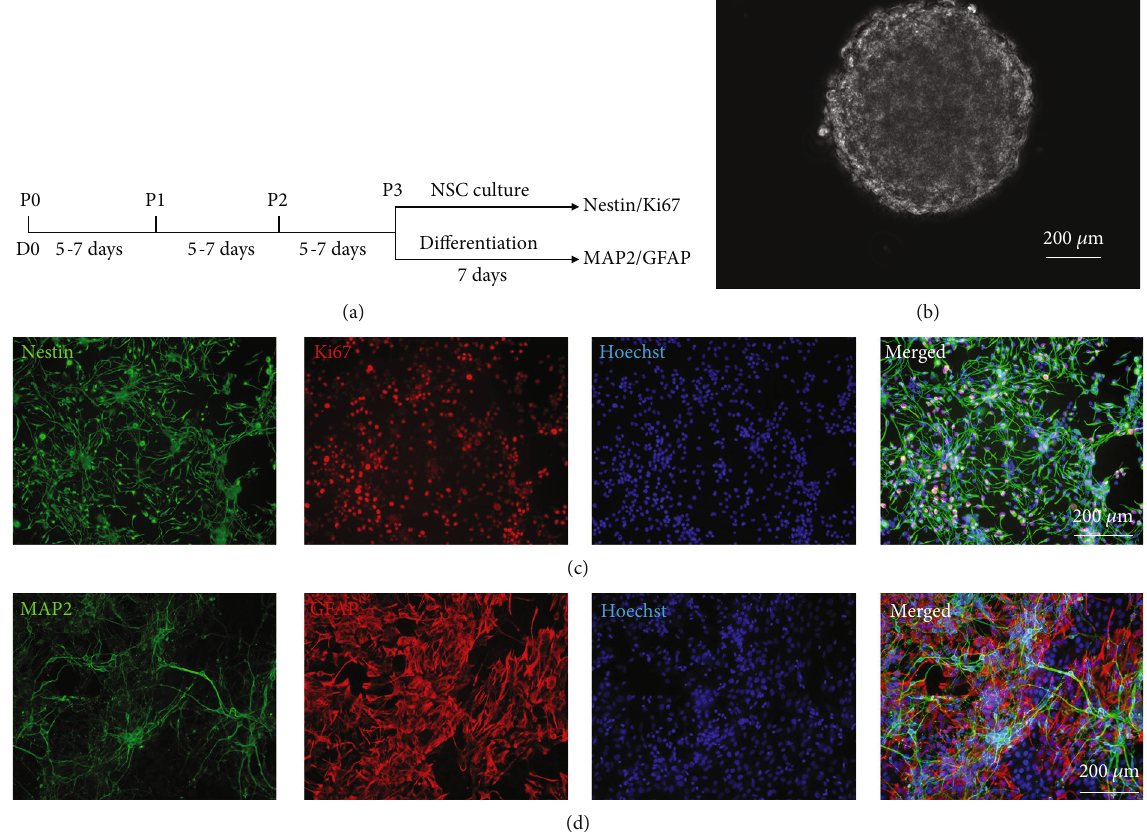
Figure 1: Culture and identi fi cation of hippocampal NSCs. (a) The schematic of the culture and di ff erentiation of NSCs. (b) A representative image showing the morphology of the third-generation neurosphere derived from the hippocampi of the neonatal (1 day) ICR mice. (c) Immunocytochemistry staining on the third generation showed that most of the cells expressed Nestin (green). and Ki67 (red). (d) After being cultured in a di ff erentiation medium for 7d, immunocytochemistry analysis showed that some cells could express MAP2 (green) and GFAP (red). Nuclei were stained with Hoechst (blue). Scale bar = 200 μ m